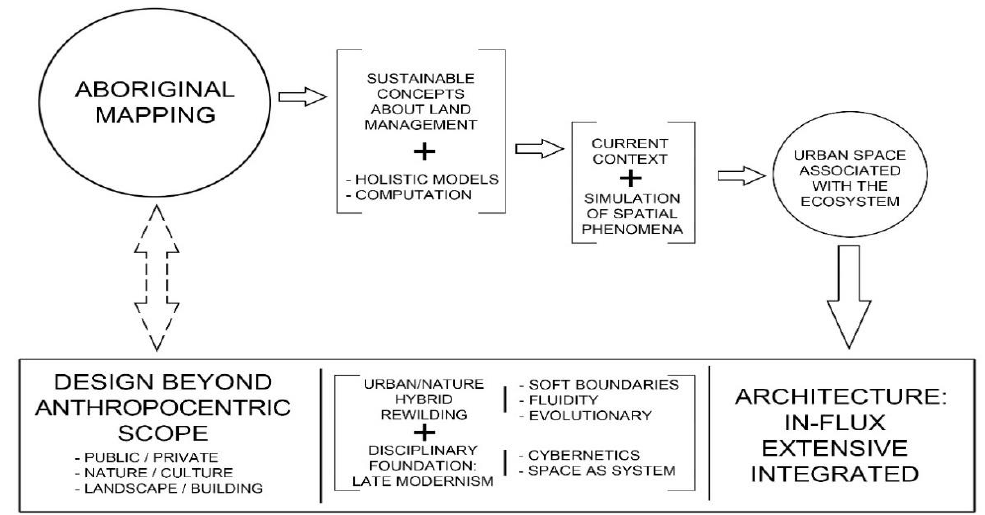
Figure 3. Methodology diagram.